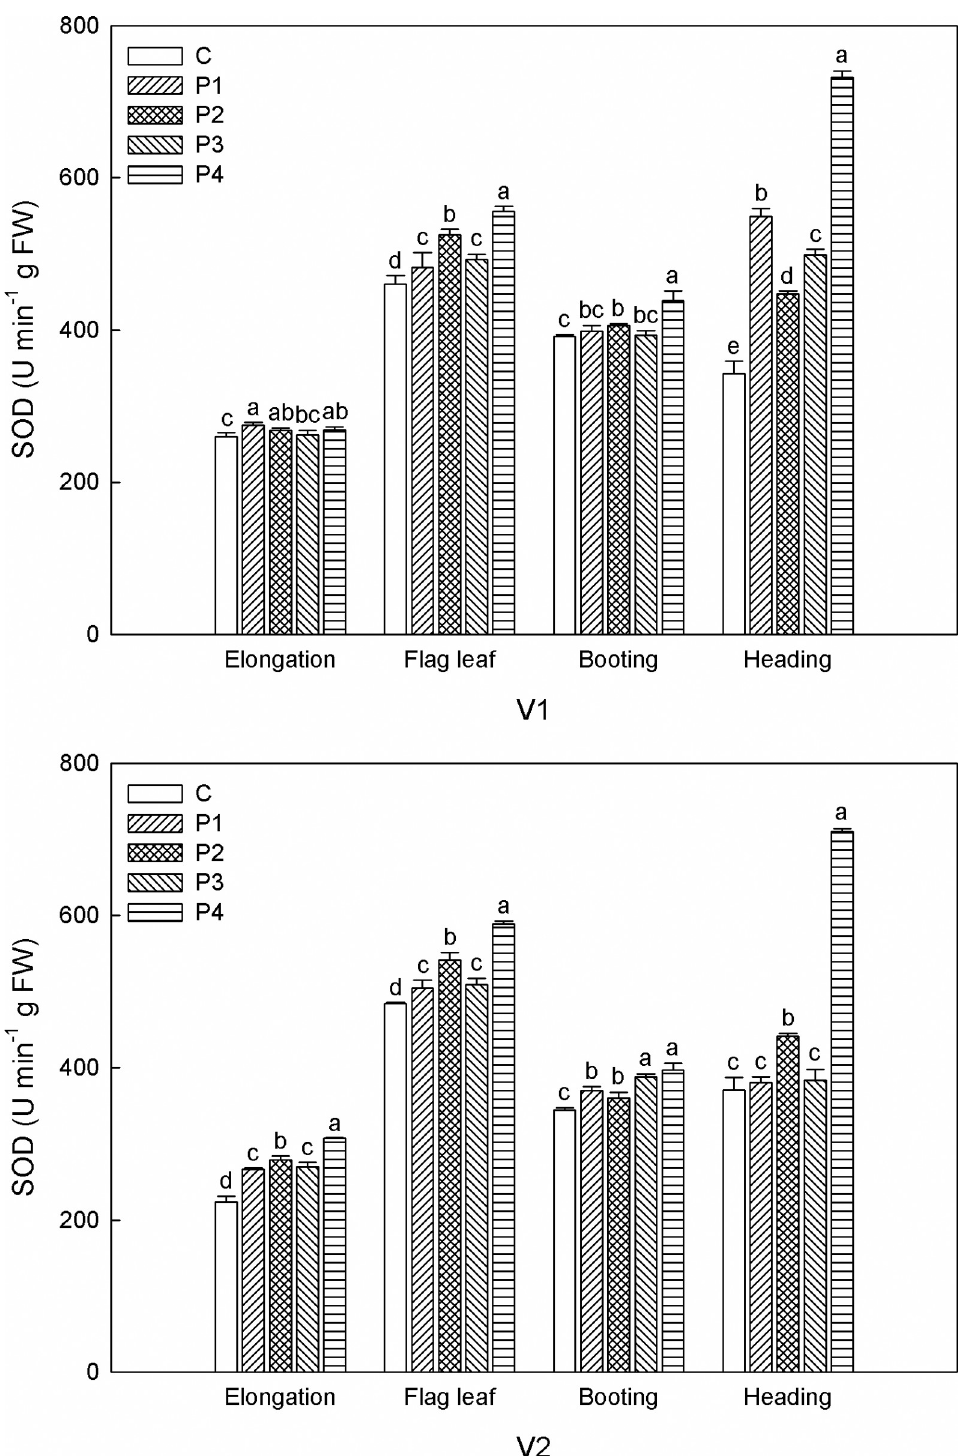
Fig 3. Effects of seed priming on SOD activity of sorghum plants under salt stress at different growth stages. P1: control, P2: H 2 O 2 , P3: NaCl, P4: KCl, P5: MgSO 4 . Within the same growth stage, the bars marked with different lowercase letters are statistically different at the 0.05 probability level.